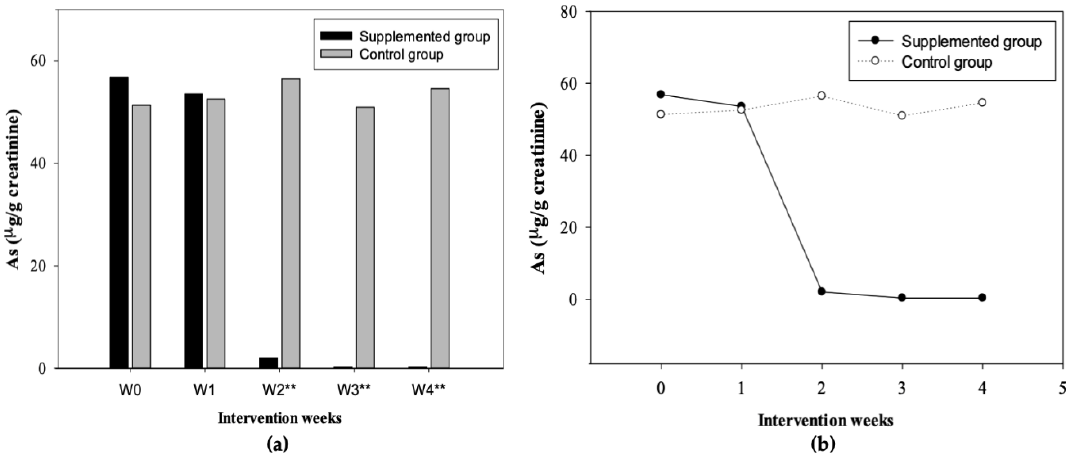
Figure 4. ( a ) Comparison of UAs (Urinary arsenic) concentrations (median) in the supplemented group and control group (W0: baseline; W1: week 1; W2: week 2; W3: week 3; W4: week 4). ** Statistically significant di ff erence between groups according to the Mann–Whitney U test ( p < 0.001); ( b ) Comparison of UAs concentration (median) between supplemented and control group per week of treatment. The Friedman and Wilcoxon tests were carried out to determine di ff erences between weeks of supplementation.